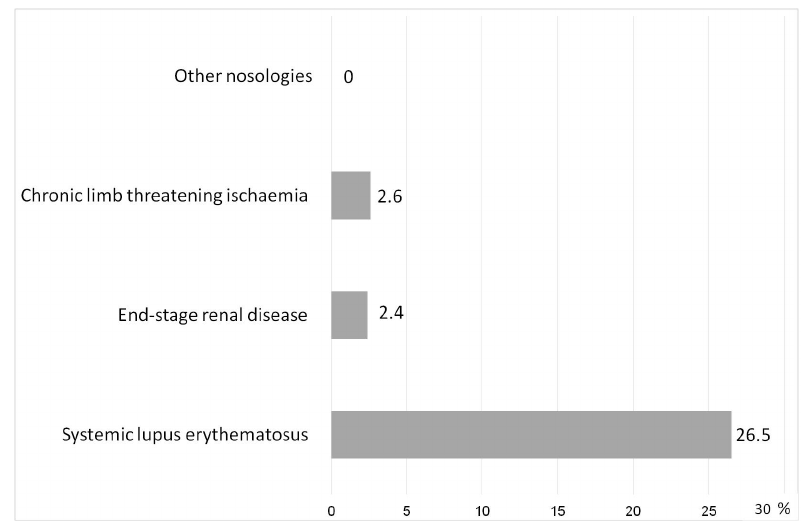
Figure 5. Rate of false positive values by the SI scale in chronic diseases (%).